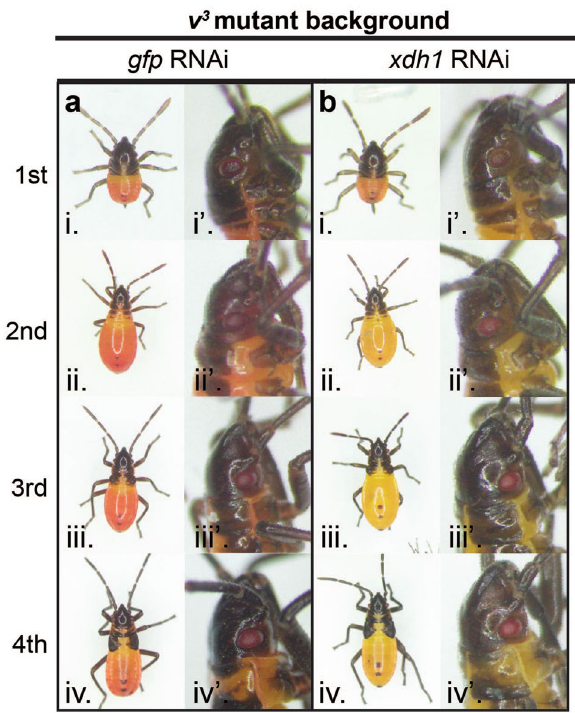
Figure 5. Of-xdh1 knockdown in Of-v 3 mutant background produces bright yellow body color. Offspring of v 3 mothers treated with gfp ( A ) or Of-xdh1 ( B ) dsRNA were observed at first (i), second (ii), third (iii), and fourth (iv) instars. While the knockdown did not appear to produce an effect in the eyes of pRNAi offspring